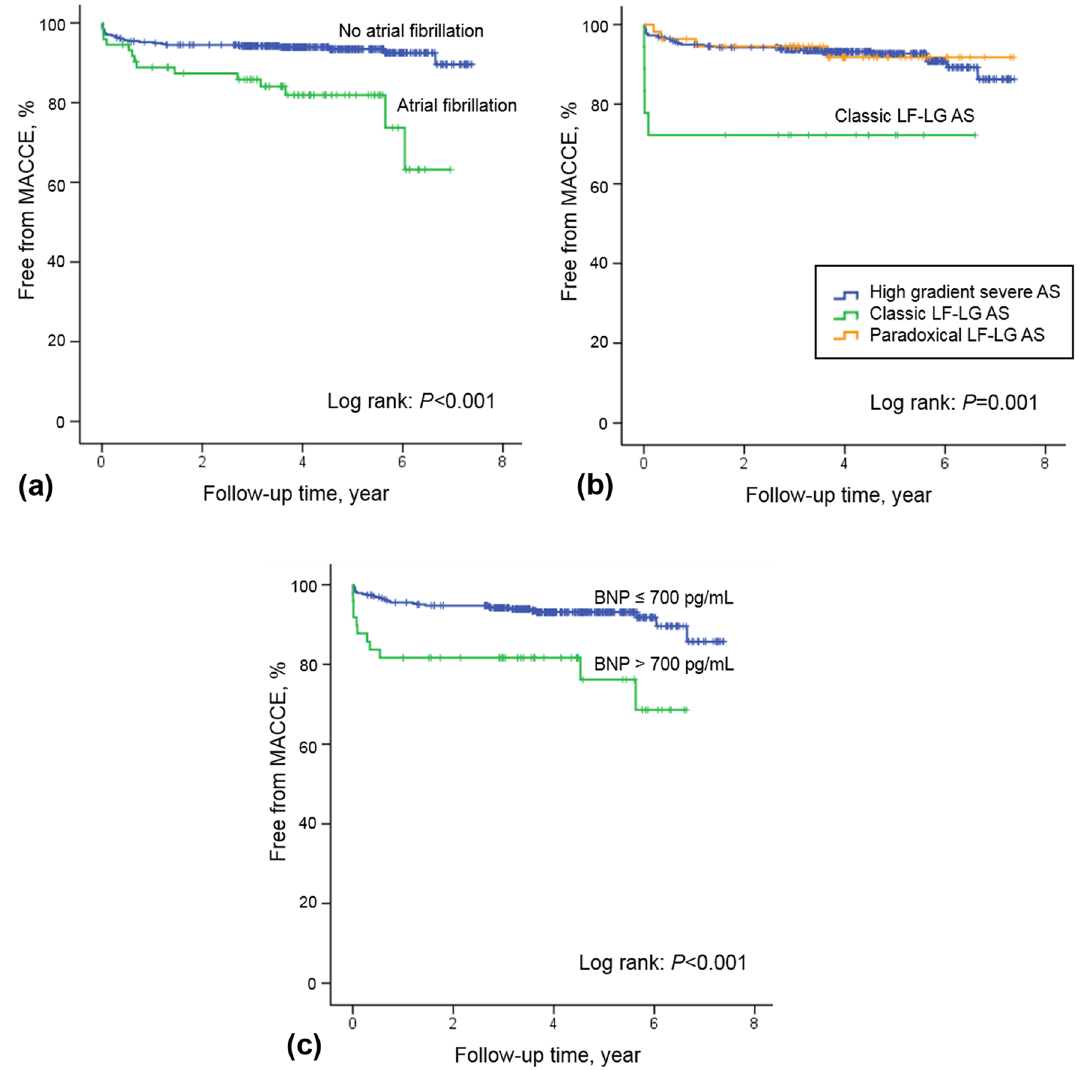
Figure 4. Survival according to ( a ) B-type natriuretic peptide, ( b ) presence of atrial fibrillation, and ( c ) categories of aortic stenosis. AS aortic stenosis, LF-LG low-flow and